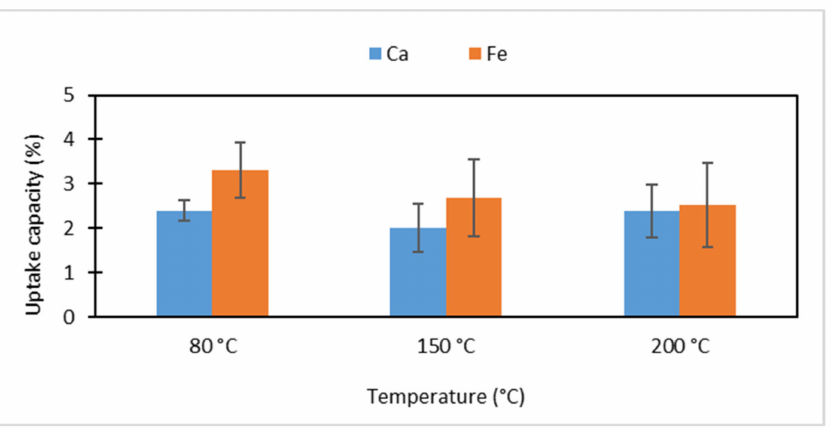
Figure 9. Average Ca and Fe uptake capacity (%) for different reaction temperatures of Fe-rich mine waste. Error bars represent standard error of the mean